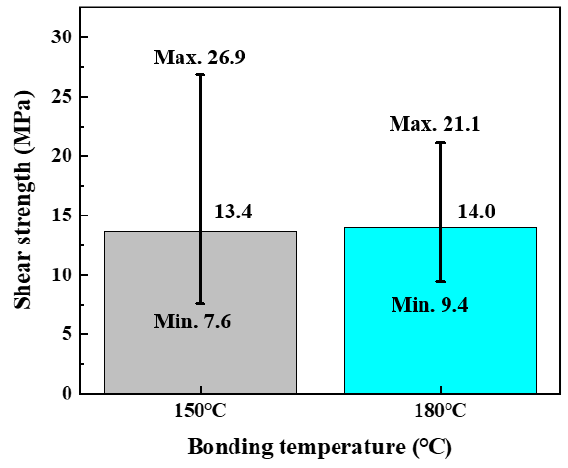
Figure 6. Shear strength measurements of Cu/Ag-Ag/Cu bonded samples.